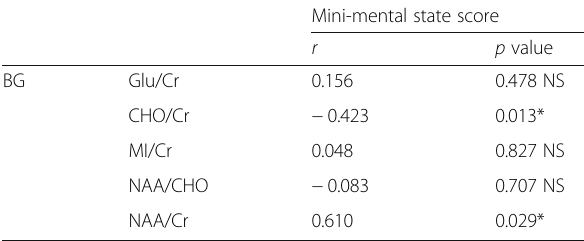
Table 4 Mini-mental state score and PCR of HCV in the study group